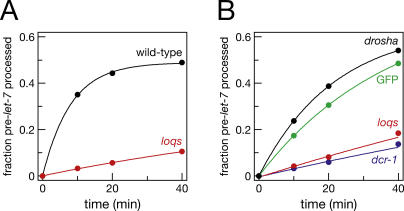
Loqs Is Required for Efficient pre-let-7 Processing In Vitro(A) loqs
f00791 mutant ovary lysates processed pre-let-7 into mature let-7 miRNA ∼19-fold more slowly than wild-type. The data were fit to a first-order exponential equation, and initial velocities calculated from the fitted curve.(B) Analysis of pre-let-7 processing in extracts from S2 cells. The cells were treated twice with dsRNA corresponding to the indicated genes.